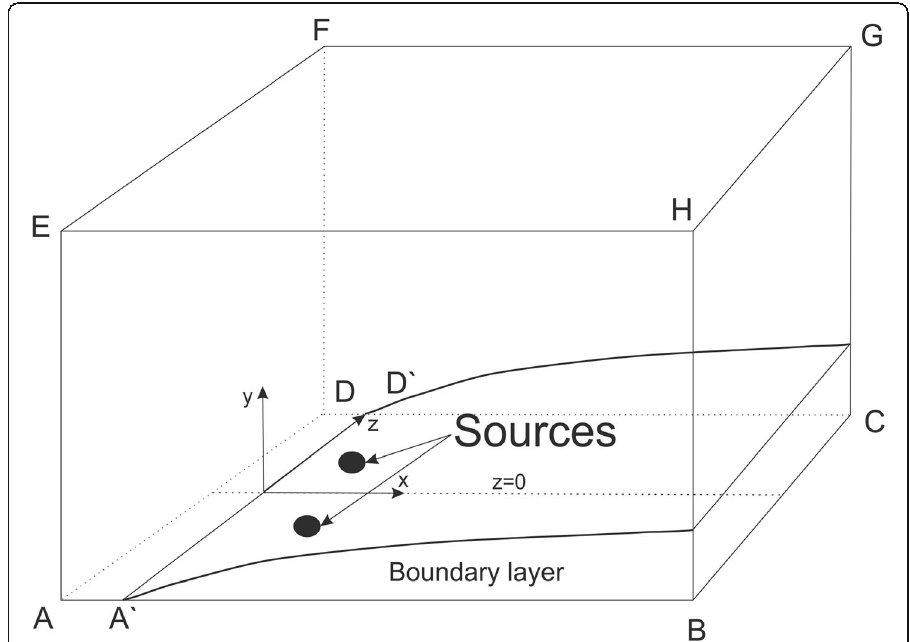
Fig. 1 Scheme of flat plate model, coordinate systems used, sources and computational